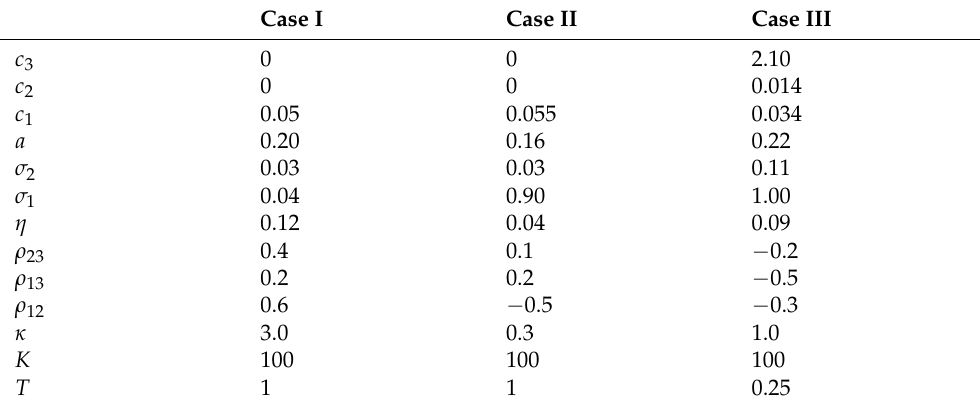
Table 1. The values of the constants in PDE (3).